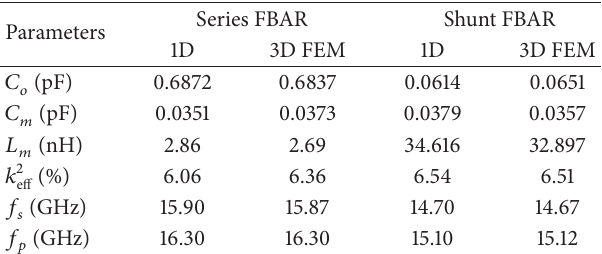
Table 5: Comparisons of 1D and 3D FEM of Filter A.